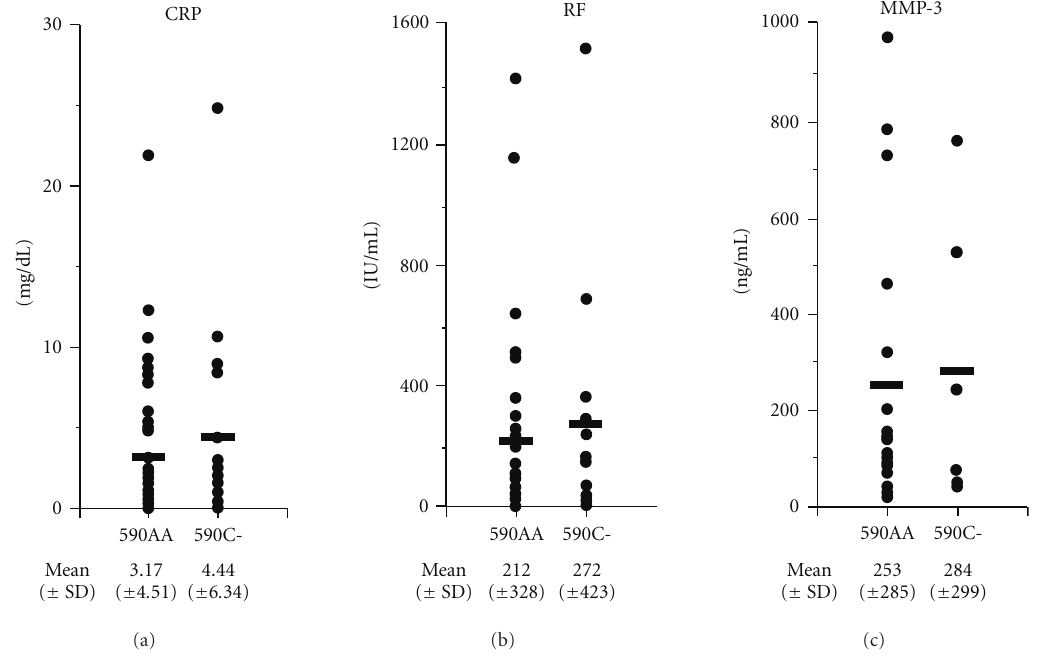
Figure 1: Disease profiles of rheumatoid arthritis patients with 590A/A and 590C SNPs of BTLA gene. Titers of C-reactive protein (CRP), rheumatoid factor (RF), and matrix metalloproteinase-3 (MMP-3) at the first visit to the hospital in RA patients with 590A/A and 590C (590A/C and C/C); SNPs of BTLA gene are shown.